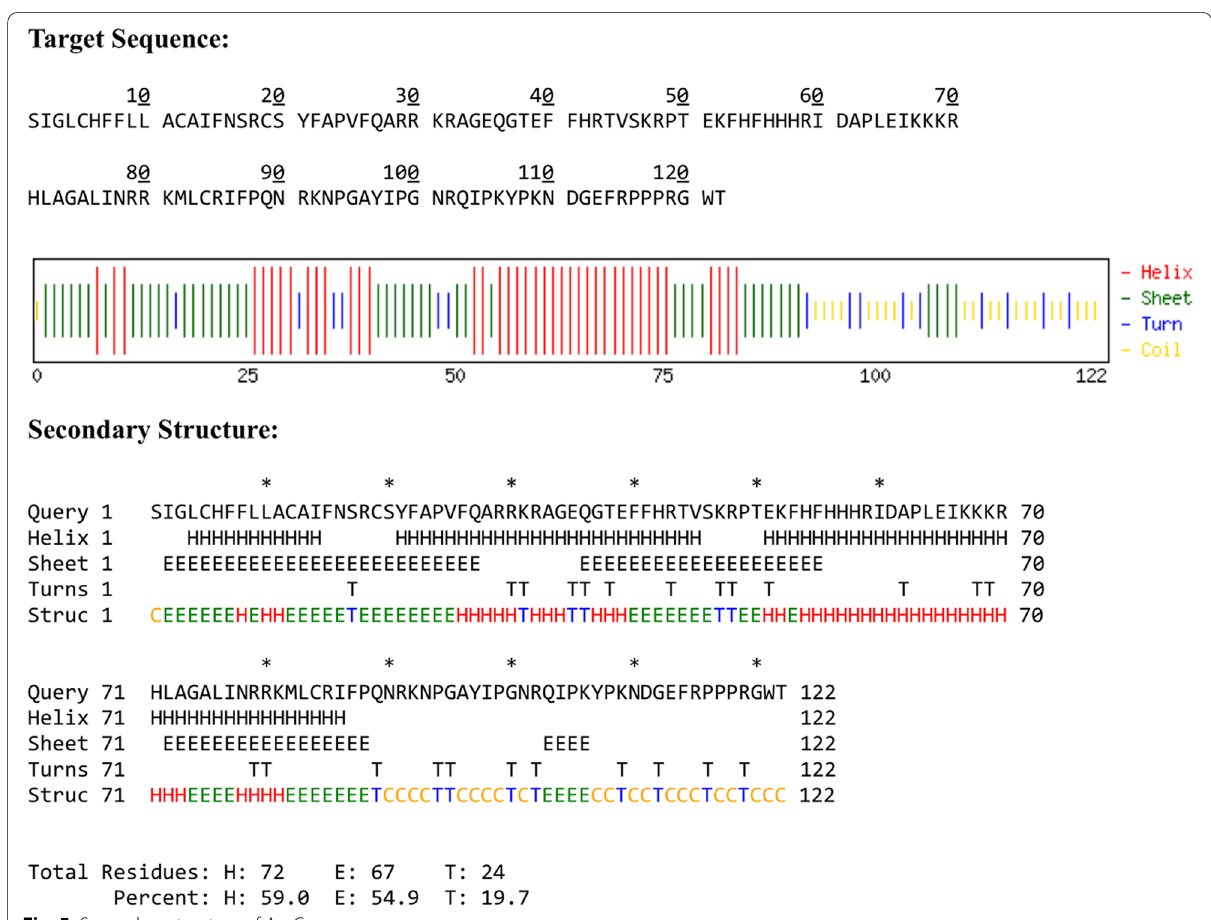
Fig. 5 Secondary structure of AmCoc